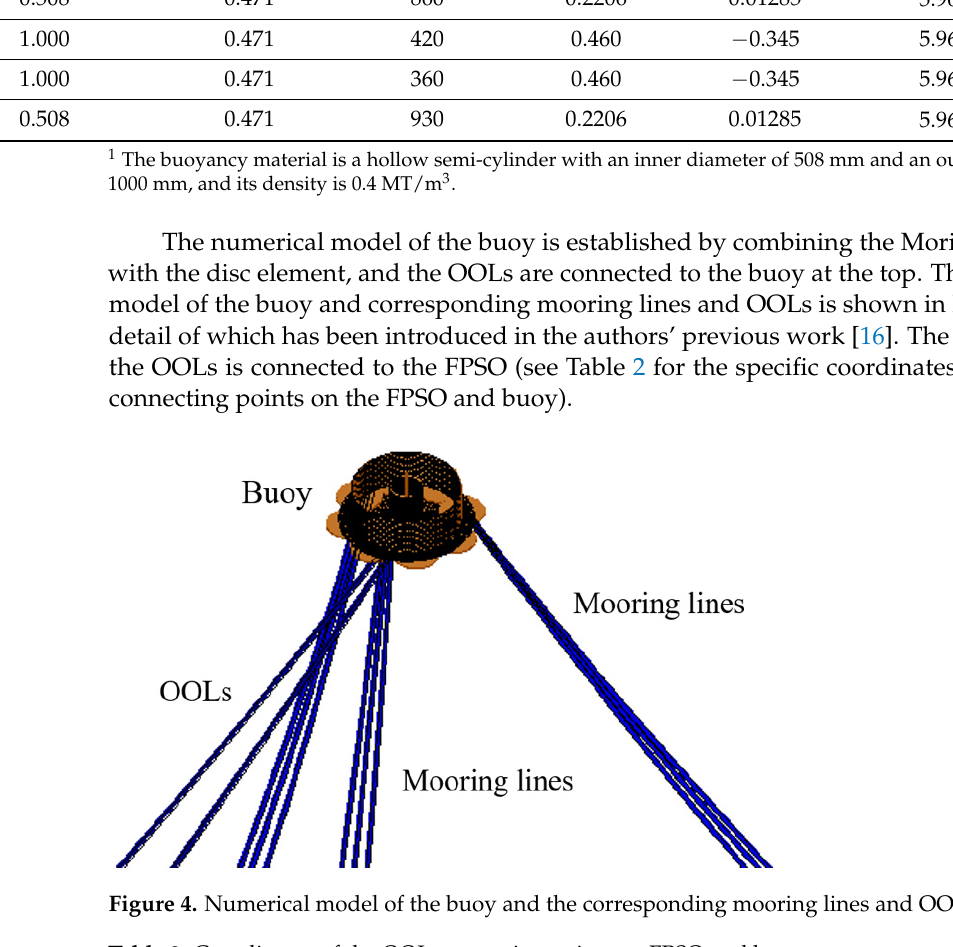
Table 1. Detailed attributes of the OOLs.